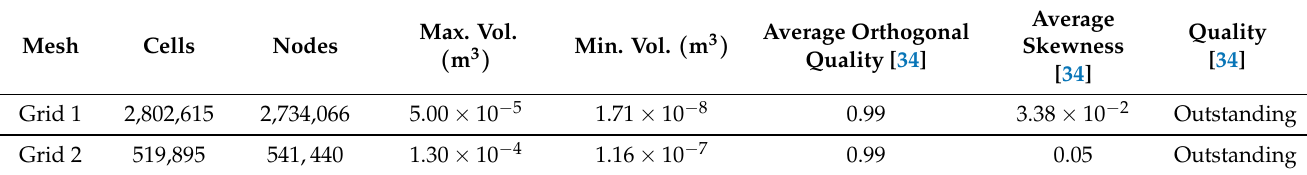
Table 1. Mesh information of the considered numerical modelling.